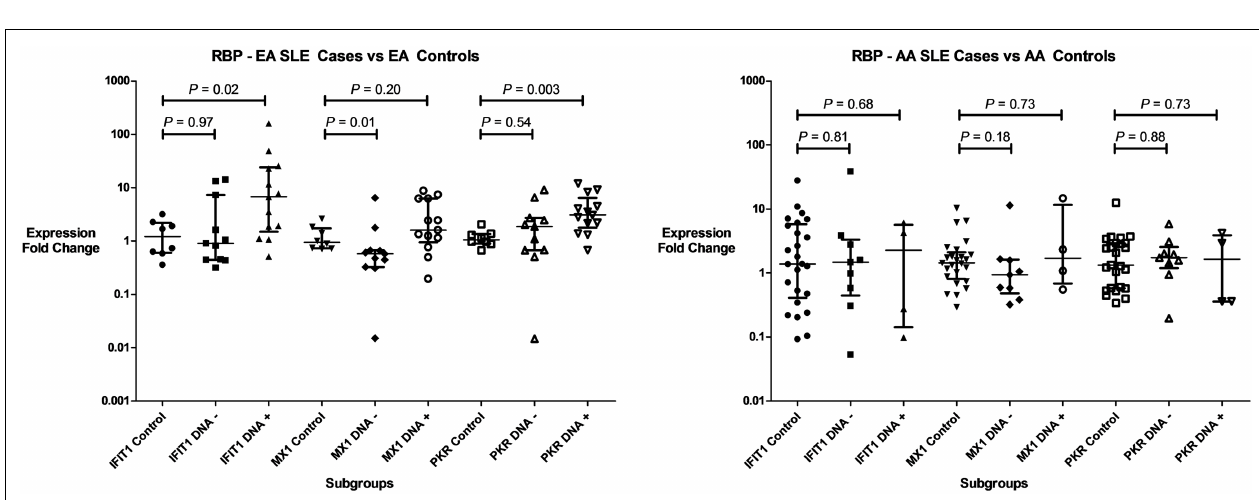
with anti-dsDNA antibodies (DNA + ), and those who lack those antibodies (DNA − ). Central tendency shown is a median, with error bars representing the interquartile range. P values generated by Mann–Whitney U